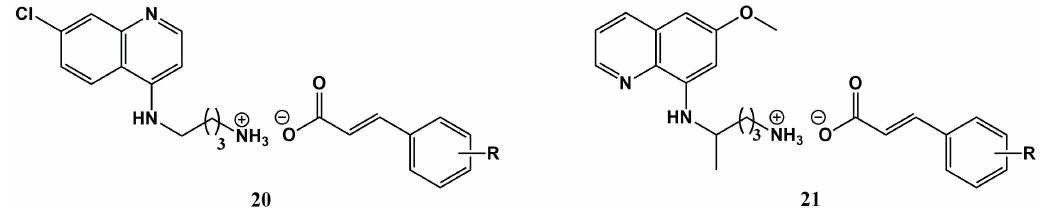
Figure 9. Antimalarial drug-cinnamic acid ionic liquids developed by Ferraz et al. [85,92–94].